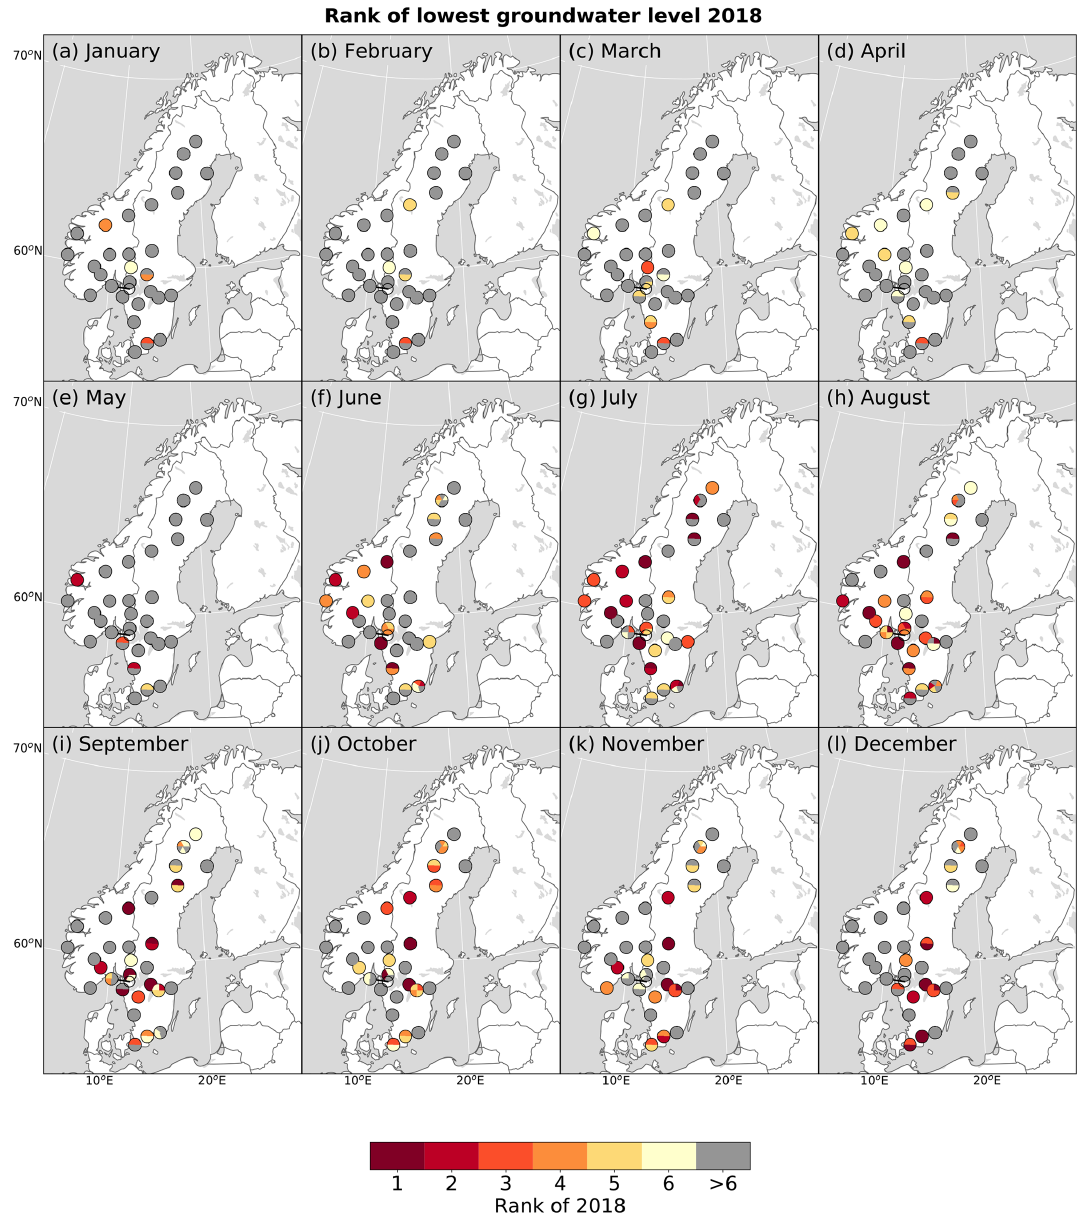
Figure A9. Top-six ranking of 2018 monthly lowest groundwater level relative to the 60-year period (1989–2018).